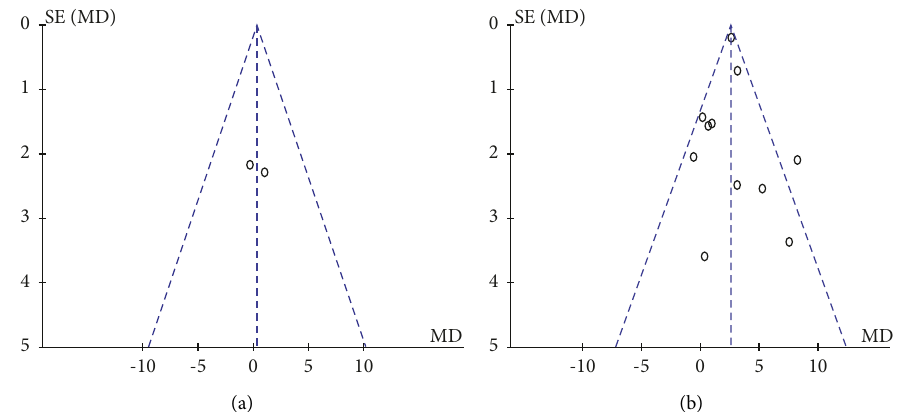
Figure 4: (a) Funnel plot for publication bias in GPi-DBS studies. (b) Funnel plot for publication bias in STN-DBS